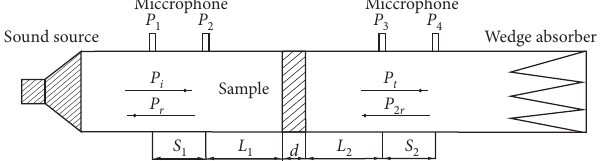
Figure 4: Boundary condition.